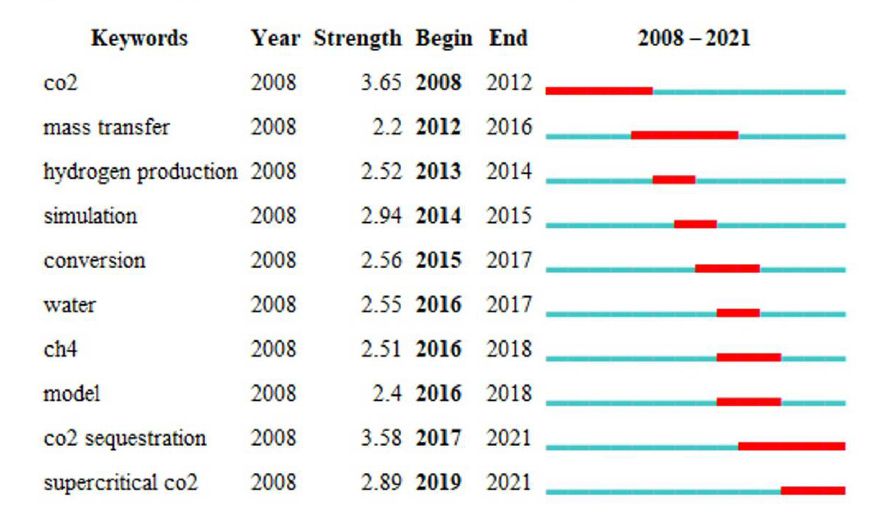
Figure 26. Keyword